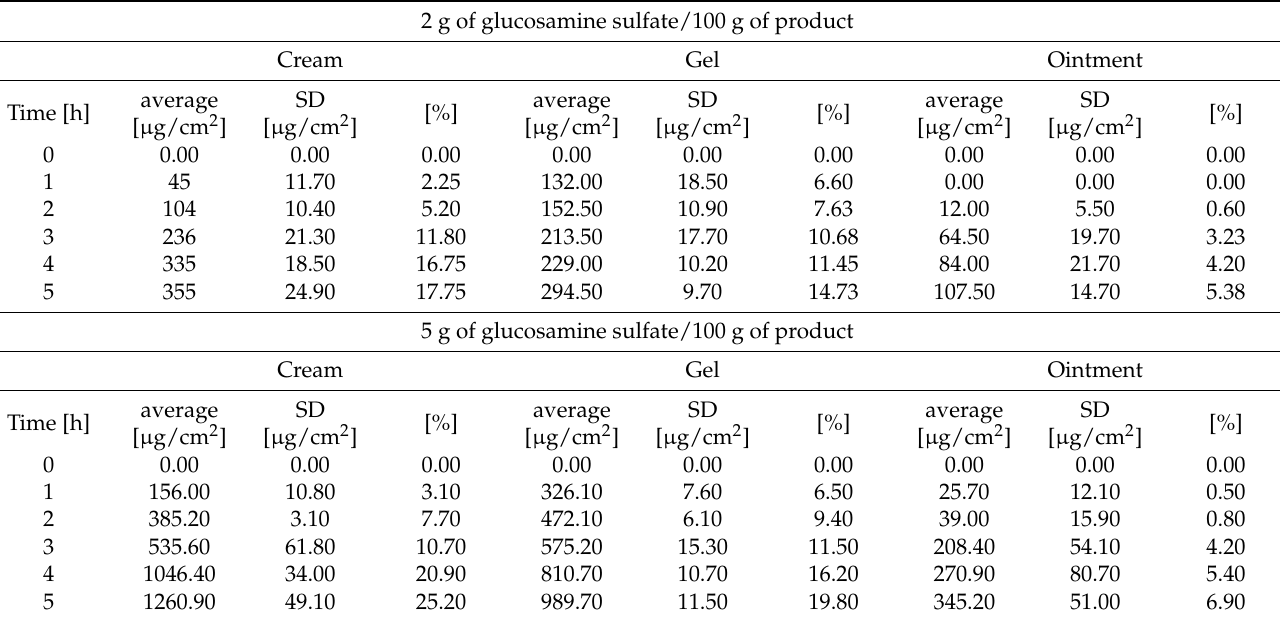
Table 4. In vitro cumulative glucosamine release